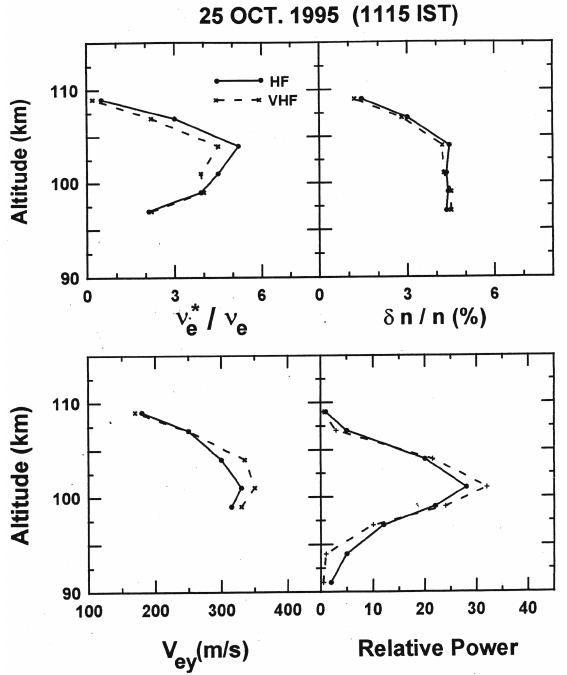
Fig. 4. Altitude profiles of ν ∗ e / ν e , δ n/n, corrected V ey and relative power (in arbitrary units) corresponding to 11:15 on 25 October 1995, from HF and VHF radar observations. Fig. 5. Daytime variation of corrected V